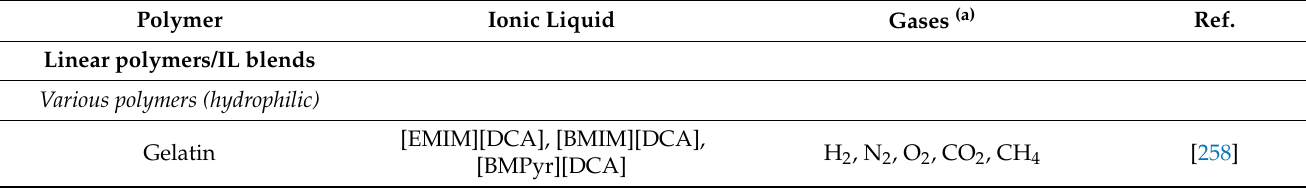
Table 6. Polymer/IL blends reported in the literature for pure gas permeation and mixed gas separation. Polymer Ionic Liquid Gases (a) Ref. Linear polymers/IL blends Various polymers (hydrophilic)